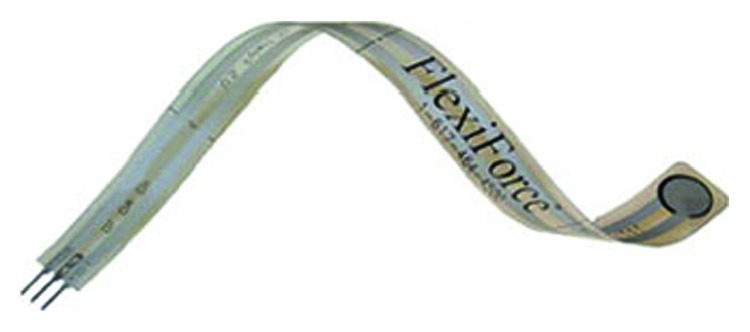
FlexiForce® sensor.